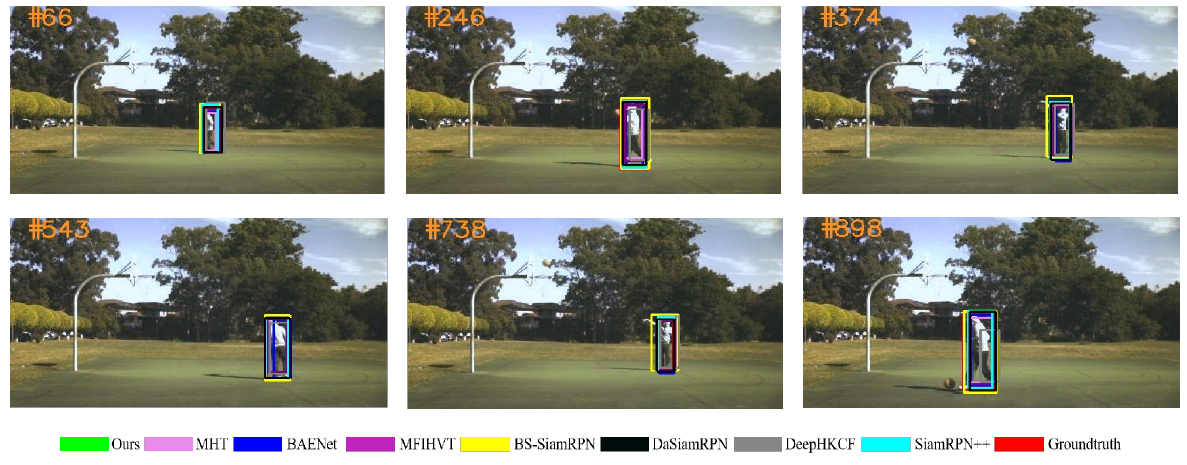
Figure 14. Qualitative results on the player